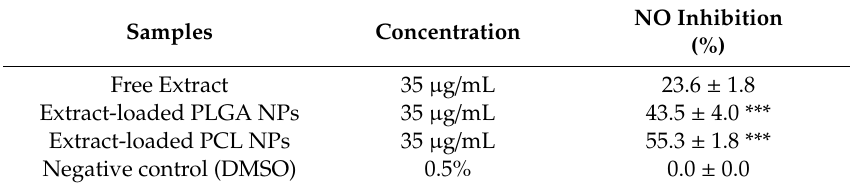
Table 2. In vitro AIA: NO inhibition values relative to LPS-stimulated RAW264.7 macrophages incubated with free extract and with extract-loaded NPs (mean ± S.E.M., n = 6, *** p < 0.001, when compared to the free extract).